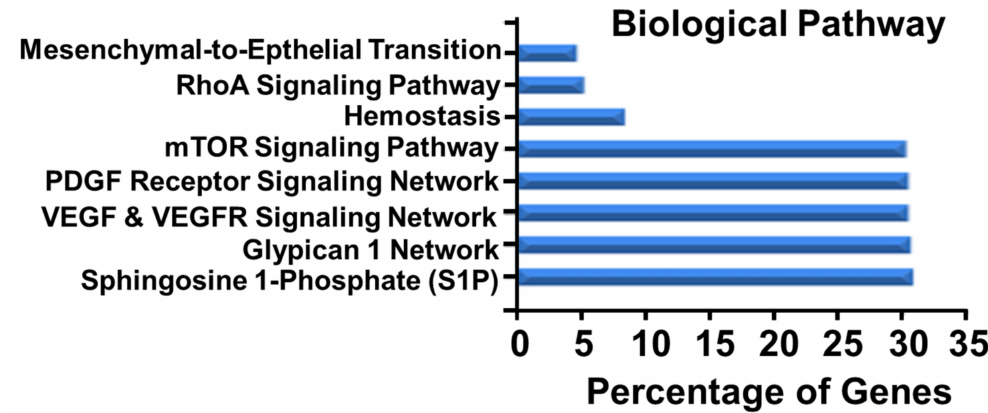
Figure 6. UniProt ID of the detected proteins reveal total of 321 miRNAs through conversion by using FunRich miRNA enrichment tools. Bar graph depicts miRNA enrichment based on UniProt ID protein’s conversion characterized on their Biological Pathway.